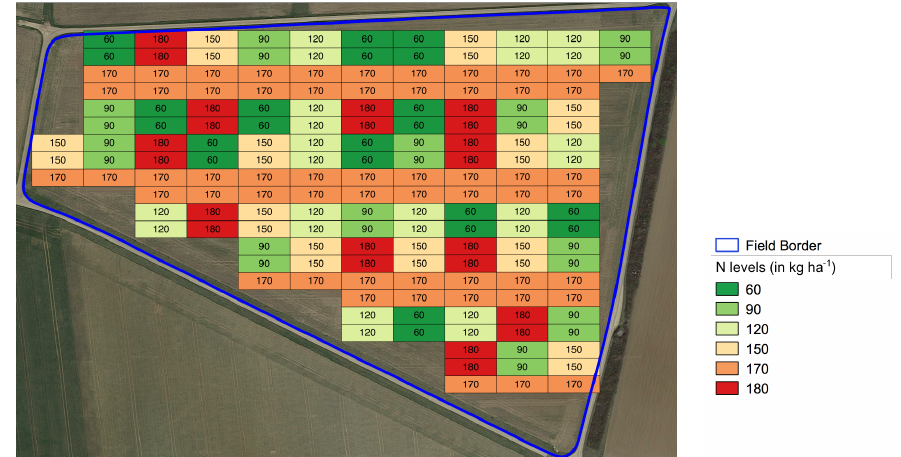
Figure 1. The colored plots reflect the different N levels in kg N ha -1 for site-year 1, as shown in the legend. Each plot has a size of 36 x 12 meter (LxW).